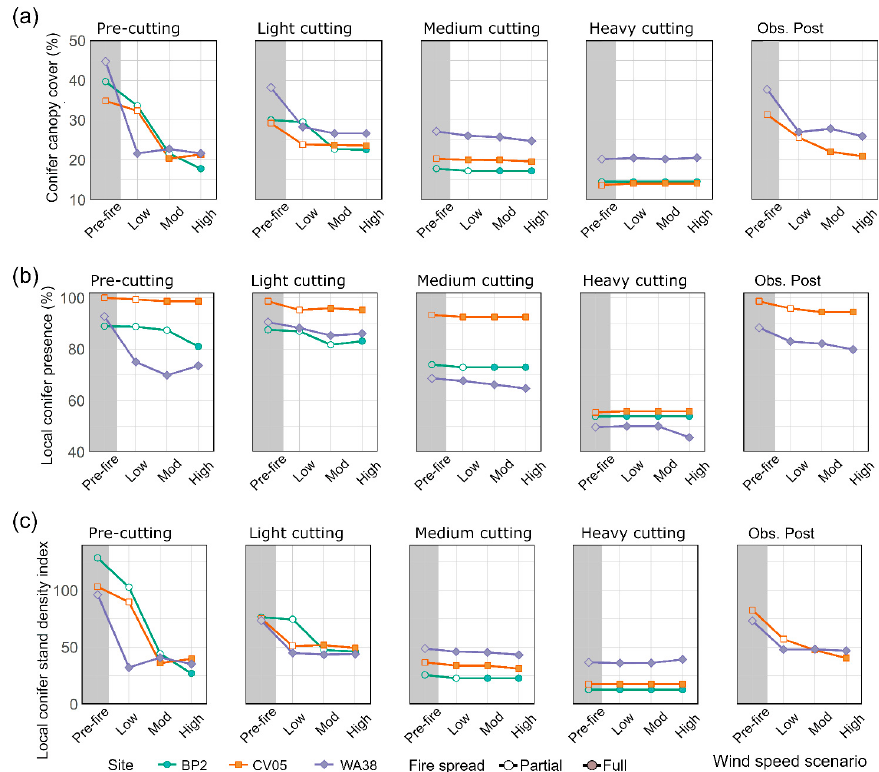
Figure 5. ( a ) Change in canopy cover, ( b ) conifer presence within 1.5 tree lengths around aspen, and ( c ) conifer stand density index within 1.5 tree lengths around aspen before fire and post-fire across open wind speeds and by cutting scenarios; hollow/filled points indicate fire spread was either partially or fully spread across the study area.